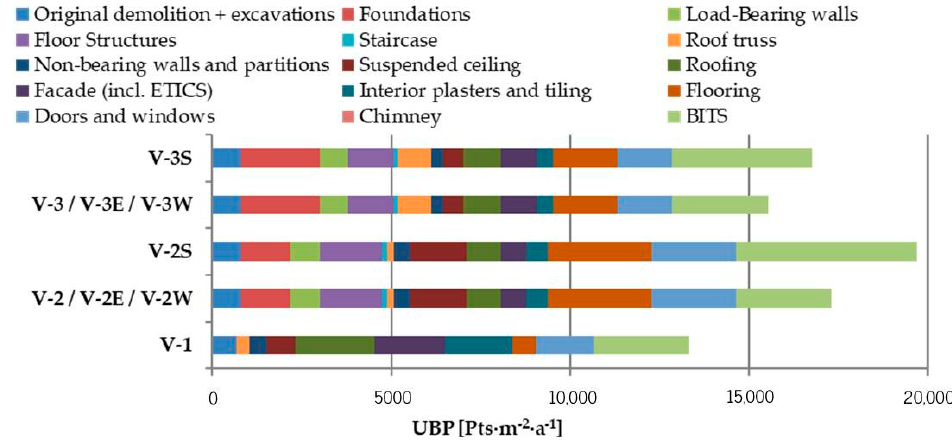
Figure 7. Embodied environmental impacts (EEIs) of the assessed variants of the house divided per construction elements.